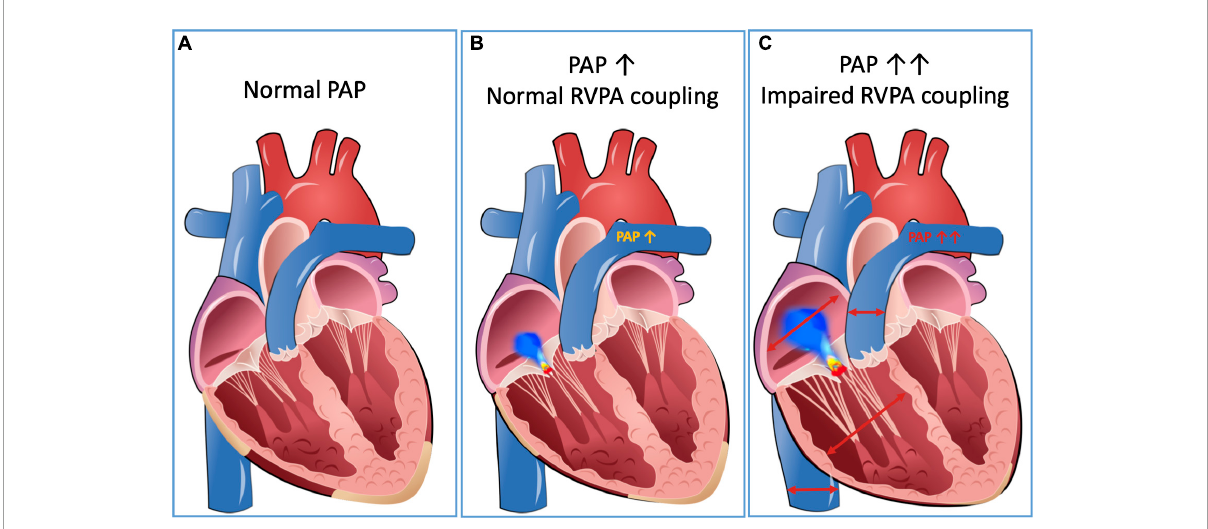
FIGURE2 RV-PA interdependency. Panel (A) represents a compensated situation with normal PAP and RV function. In panel (B) , RVPAc is intact, and the RV can compensate increasing afterload by mild dilation. In panel (C) , RVPA uncoupling occurs, which is accompanied by significant TR and dilation of the IVC. IVC, inferior vena cava; PAP, pulmonary artery pressure; RV, right ventricle; RVPA, right ventricular to pulmonary artery; TR, tricuspid